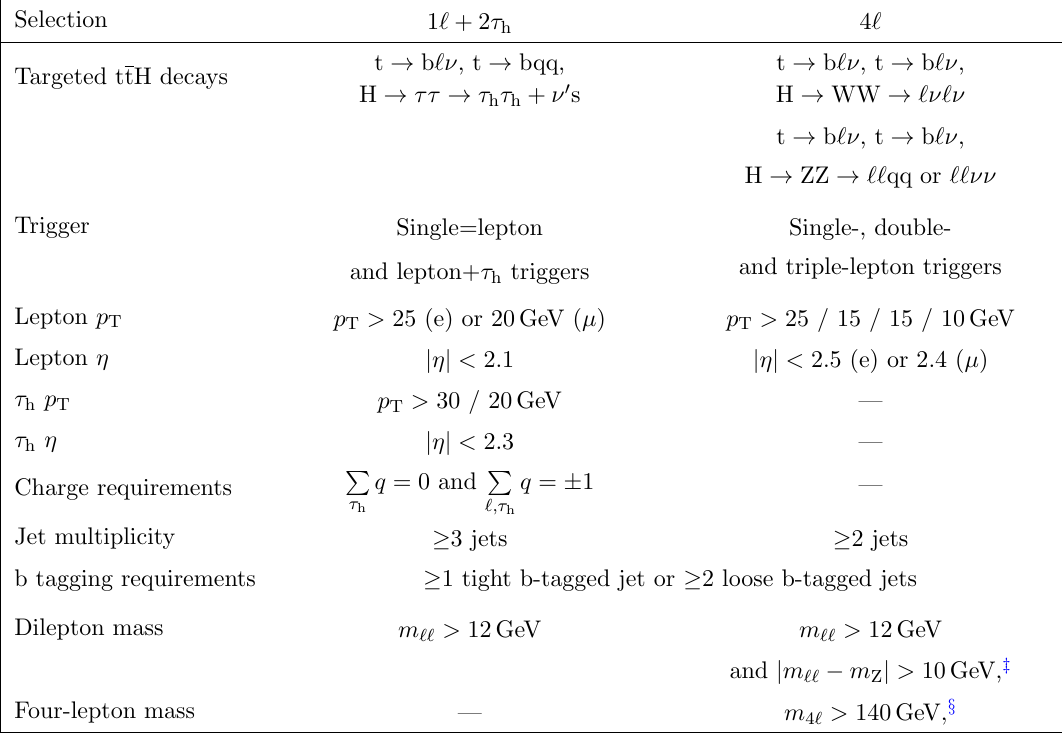
Table 2 . Event selections applied in the 1 ‘ + 2 (cid:28) h and 4 ‘ categories. If the event contains a SFOS lepton pair and N j (cid:20)